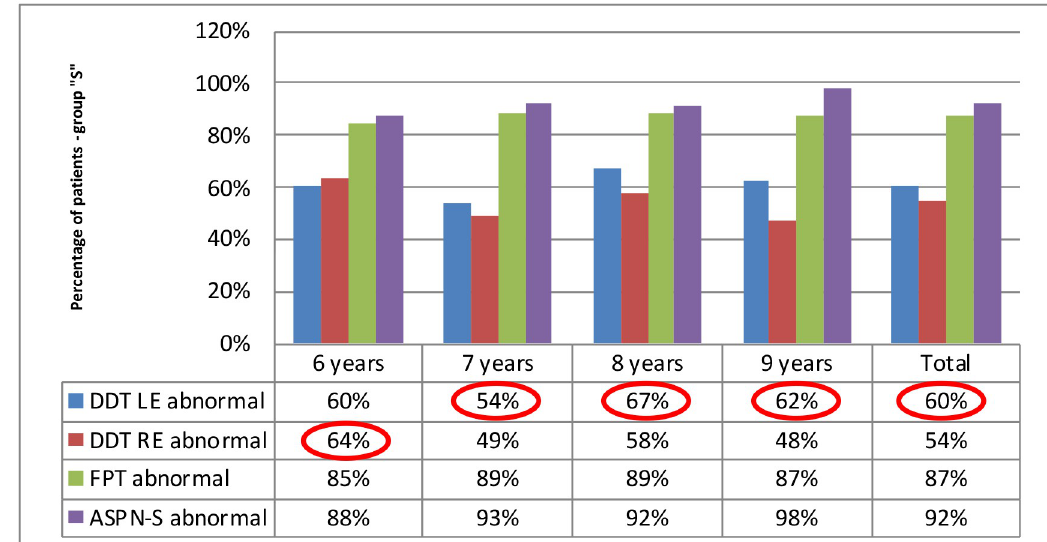
Fig 8. Percentage of abnormal APD test results, by age, in group”S”.